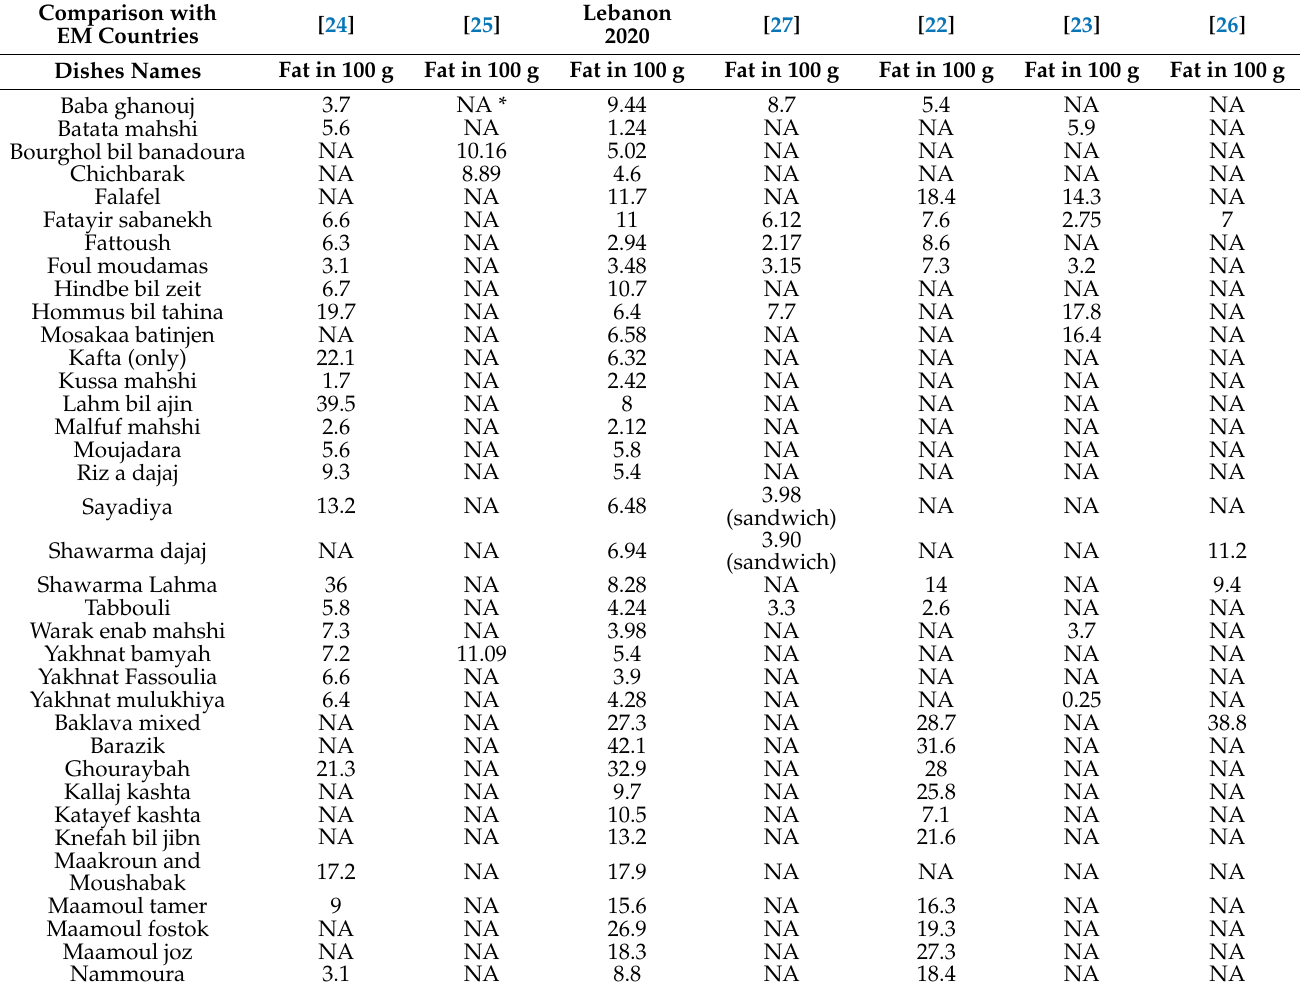
Table 4. List of fat composition of food commonly tested in Lebanon, Kuwait, Jordan, Saudi Arabia, and Bahrain [22–27]. Comparison with EM Countries